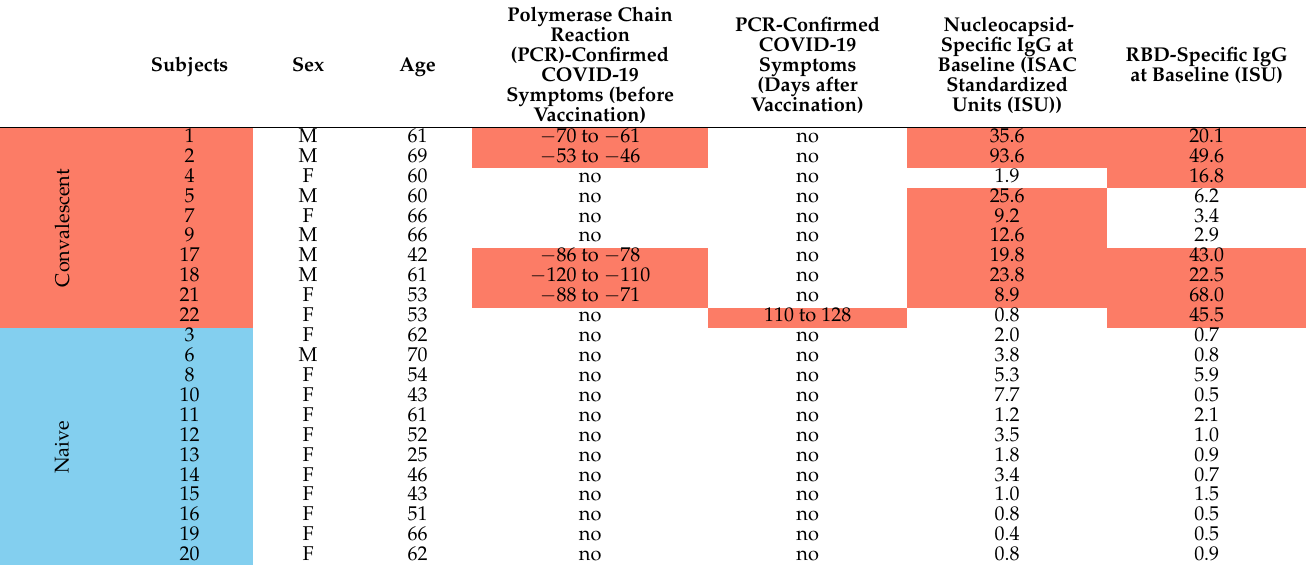
Table 1. Demographic, clinical, and serological characteristics of